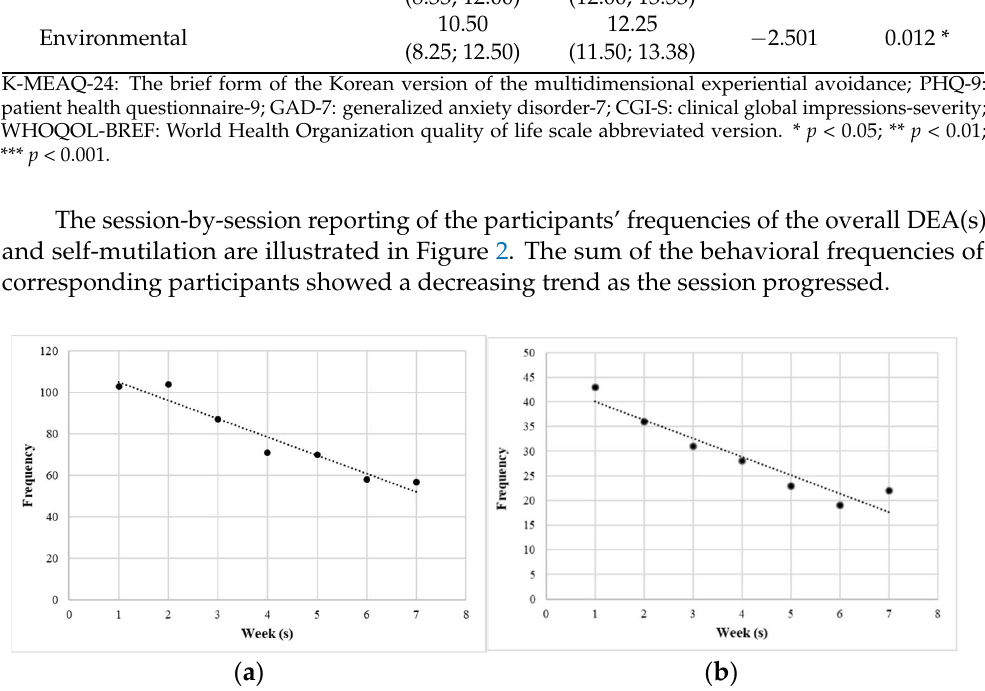
Figure 2. Trends in frequency of destructive experiential avoidance (DEA) behaviors during the study. ( a ) overall DEAs; ( b ) deliberate self ‐ harm.